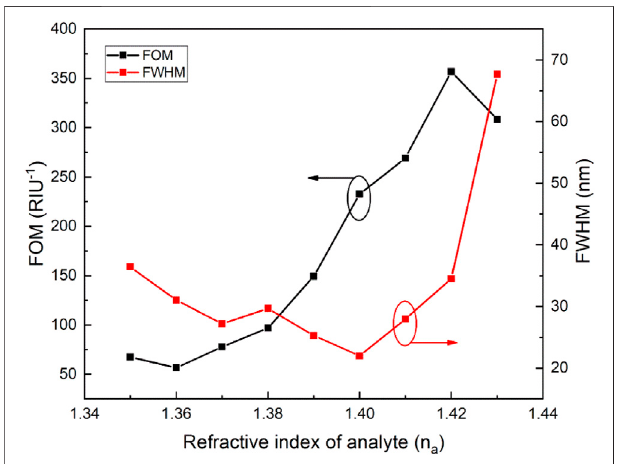
FIGURE7| VariationoftheFOMandFWHMasafunctionoftheRIofthe analyte for d (cid:2) 5 nm with t g (cid:2) 40 nm and 5% GeO 2 doped silica core.